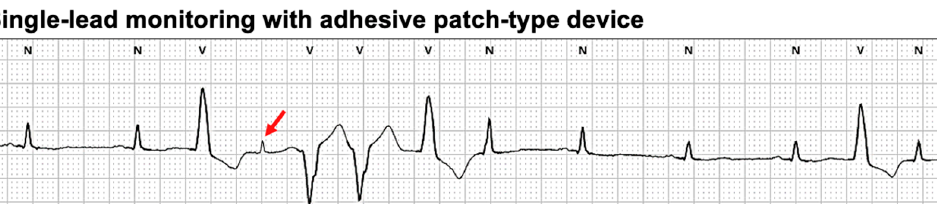
Figure 7. The outlier with significantly higher maximum heart rate with Holter monitoring. The amplitude of a particular QRS complex (red arrow) was lower than other complexes in the lead I, and this led to undersensing of the QRS complex with the MC-100. Such a particular undersensing led to different measurements of the maximum heart rate.